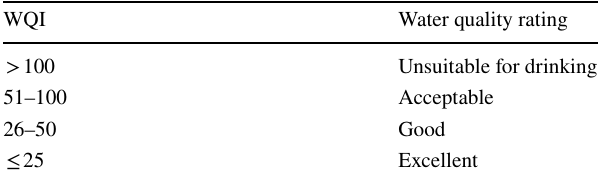
Table 3 WQI-based rating of water quality